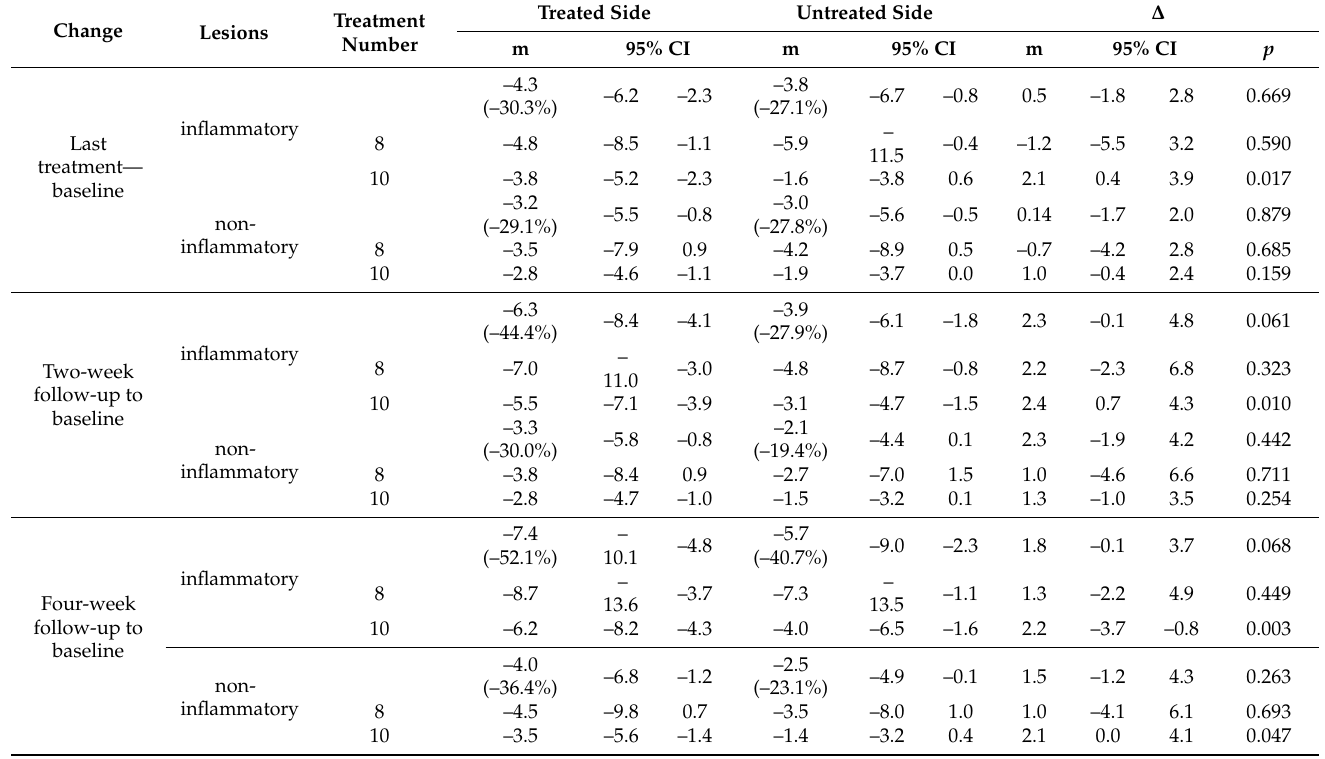
Table 3. Change in the number of lesions compared between the treated and the untreated side of the face. Change